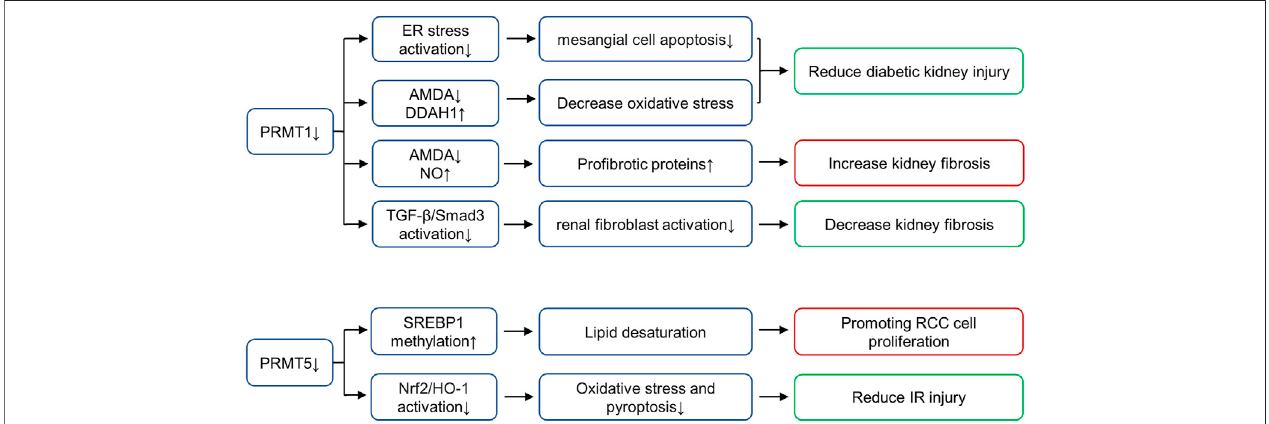
FIGURE 3 | Role of histone arginine methyltransferases in various renal diseases. PRMT1 increases oxidative stress and promotes diabetic kidney injury by regulating the metabolic axis of PRMT1-AMDA-DDAH1. PRMT1 overexpression promotes endoplasmic reticulum (ER), thus inducing mesangial cell apoptosis in DN, PRMT1 knockdown reduces the injury. Inhibition of PRMT1 can inhibit the activation of TGF- β /Smad3 signaling pathway and alleviate renal fi brosis. PRMT1 has also beenshowntoaffectNOproductionandreducerenal fi brosisthroughAMDA,andinhibitionofPRMT1canincreasethispathologicalprogression.PRMT5interacts with LINC01138 to enhance protein stability and methylation of SREBP1, further mediating lipid desaturation and promoting RCC cell proliferation. PRMT5 is also involved in ischemia- and hypoxia-induced oxidative stress and pyroptosis via activation of the Nrf2/HO-1 signal pathway. AbbreviationsPRMT, protein arginine methyltransferases; DDAH, dimethylarginine dimethylaminohydrolase; SREBP1, sterol regulatory element-binding protein 1; RCC, renal cell carcinoma; Nrf2, NF-E2- related factor; HO-1, heme oxygenase-1; ADMA, asymmetrical